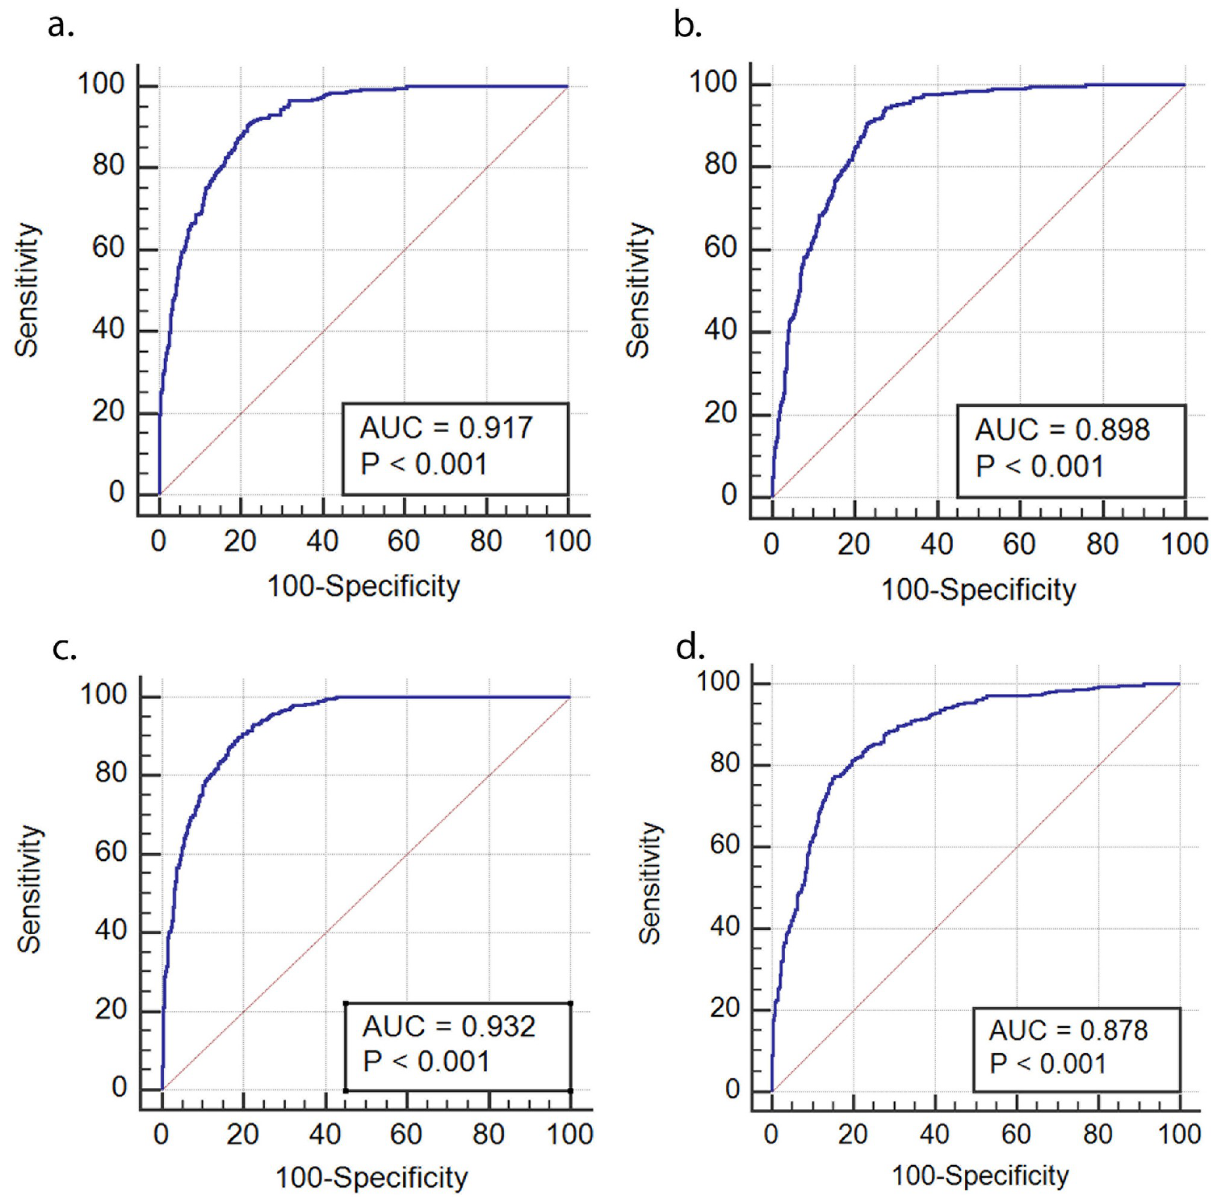
Fig 1. ROC curves for NAFLD using body fat percent. (a) ROC for Total Fat in Males (b) ROC for Abdominal Fat in Males, (c) ROC for Total Fat in Females (d) ROC for Abdominal Fat in Females.